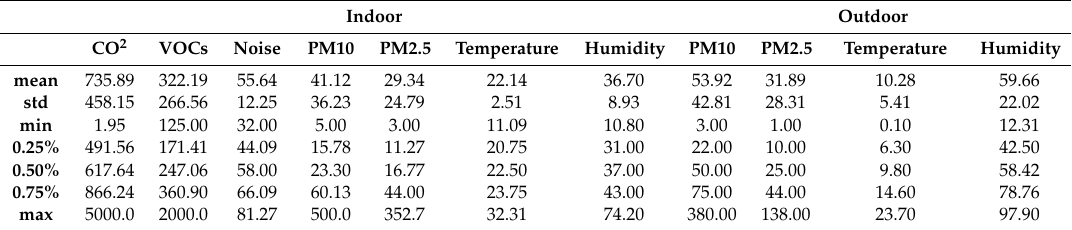
Table 3. Data distribution information of indoor and outdoor environmental